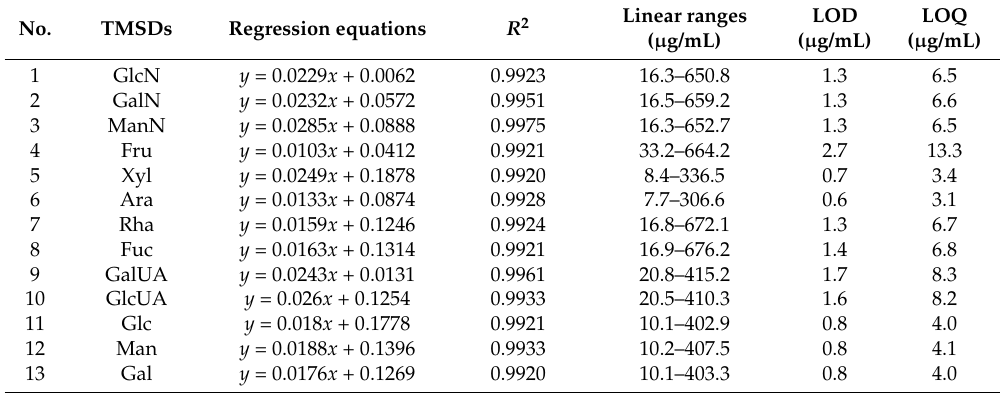
Table 2. Calibration curves and detection limit of thirteen monosaccharides based on as their TMSDs.